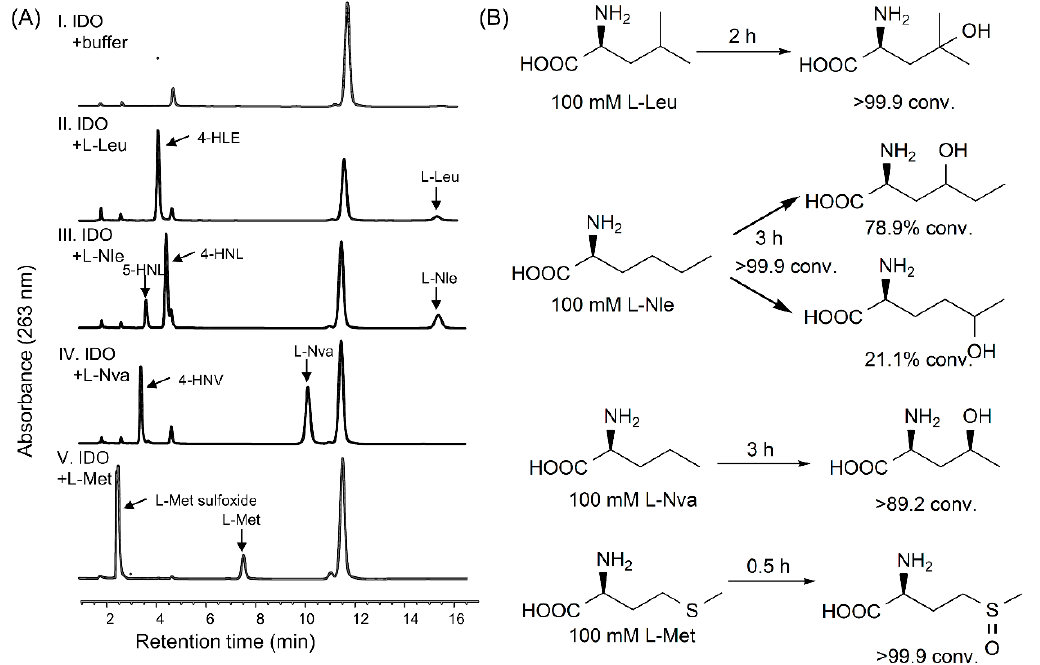
Figure 7. In vitro enzymatic synthesis of hydroxy amino acids. ( A ) Hydroxy amino acids were generated from a two-step system using various L -amino acids as substrates. Products were analyzed by LC-MS. ( B ) Biotransformation data for the productions of different hydroxy amino acids.